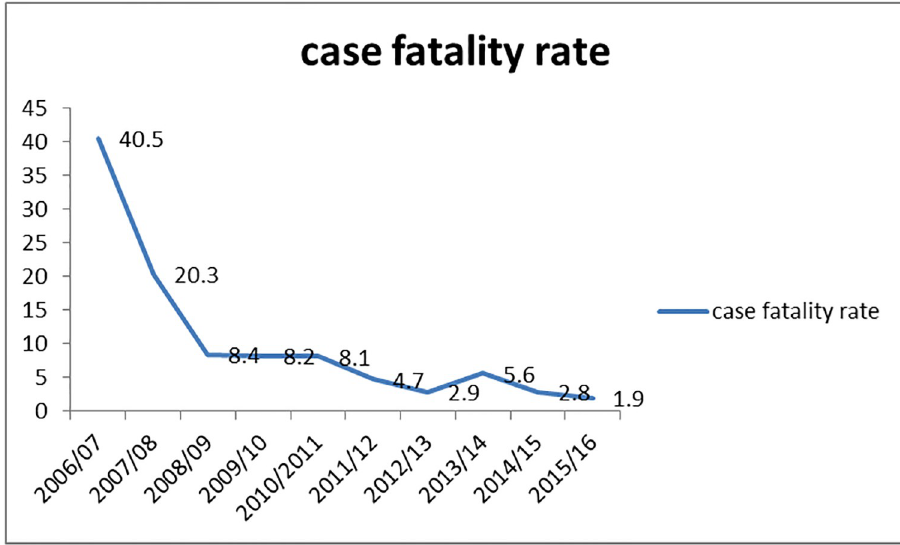
Fig 4. Trends of HVOD by case fatality rate, in Tahtay koraro district, from 2006 to 2016.